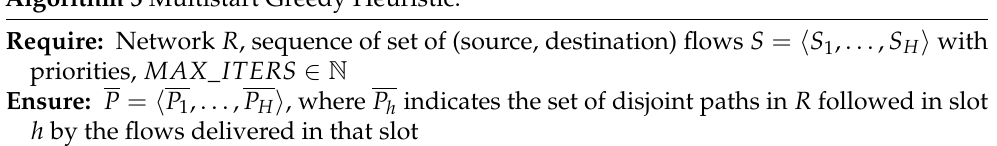
Algorithm 5 Multistart Greedy